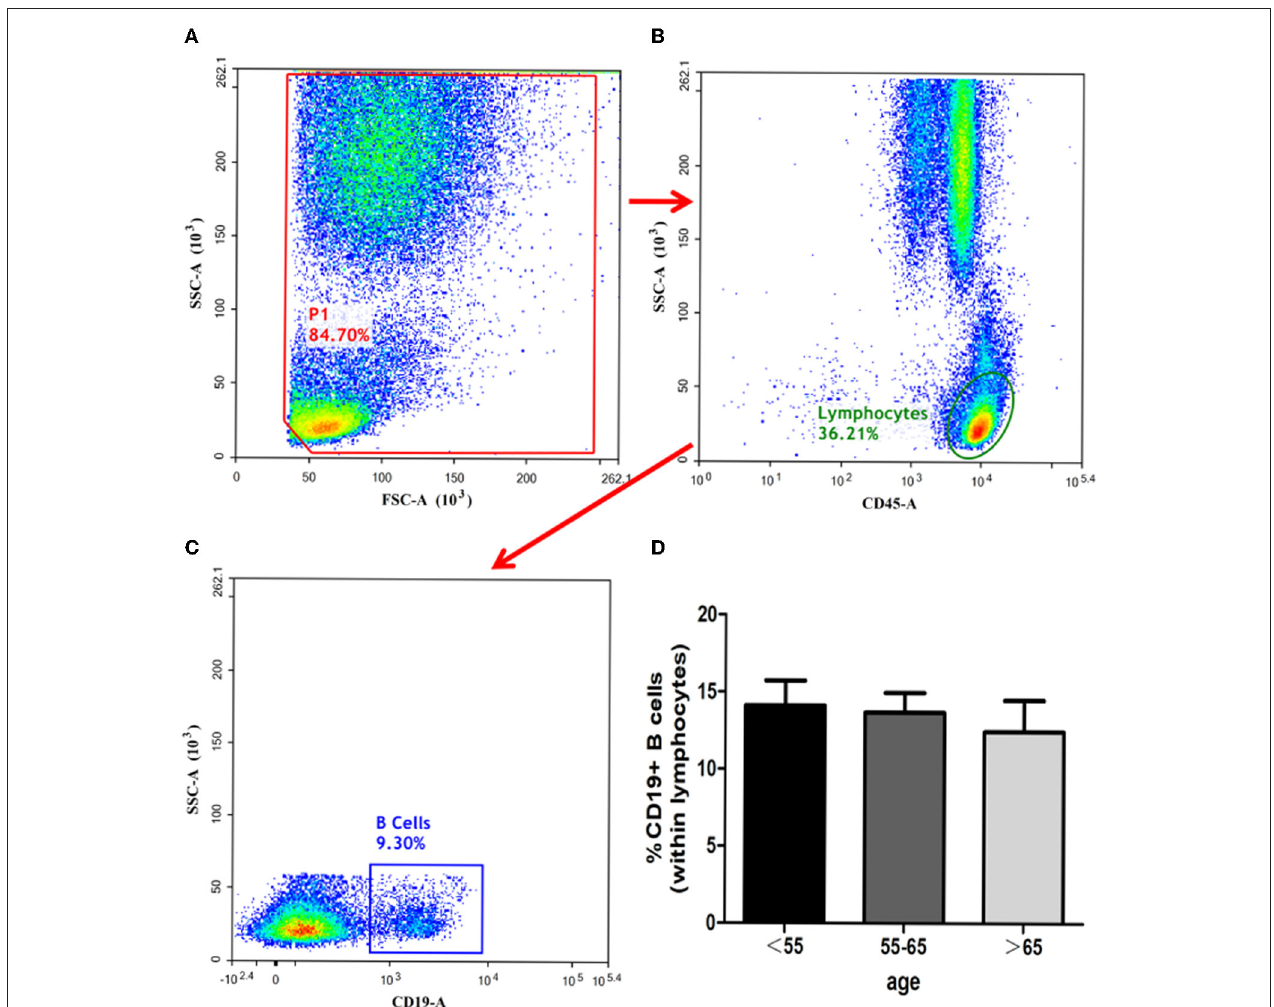
FIGURE 5 | Identification of B-cells and analysis of its subsets. B-cells identified with the gating strategy. (A) : P1. (B) : Lymphocytes. (C) : CD19 + B-Cells. Percentages of B-Cells among the 3 groups. (D) : CD19 +